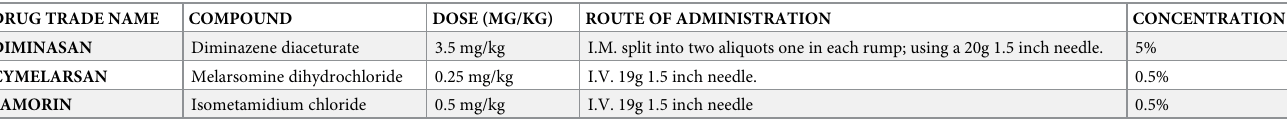
Table 1. Summary of the doses and routes of administration selected for the three